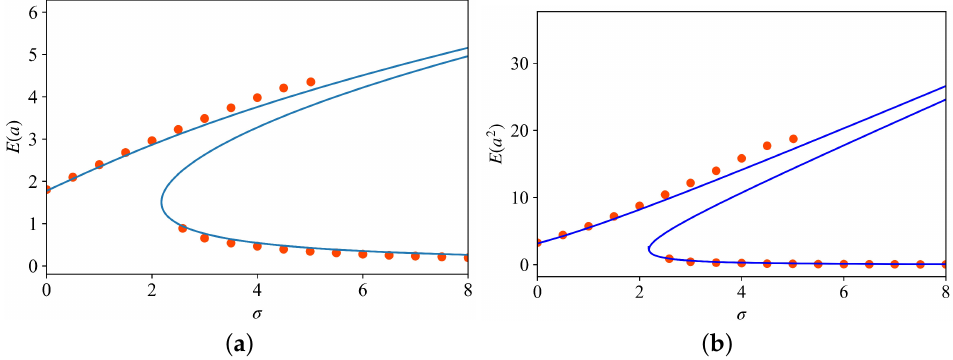
Figure 3. The variations in the mean amplitude ( a ) and the mean-square amplitude ( b ) with different detuning frequency σ . − : analytical results of (6); • : Monte Carlo results of (6).